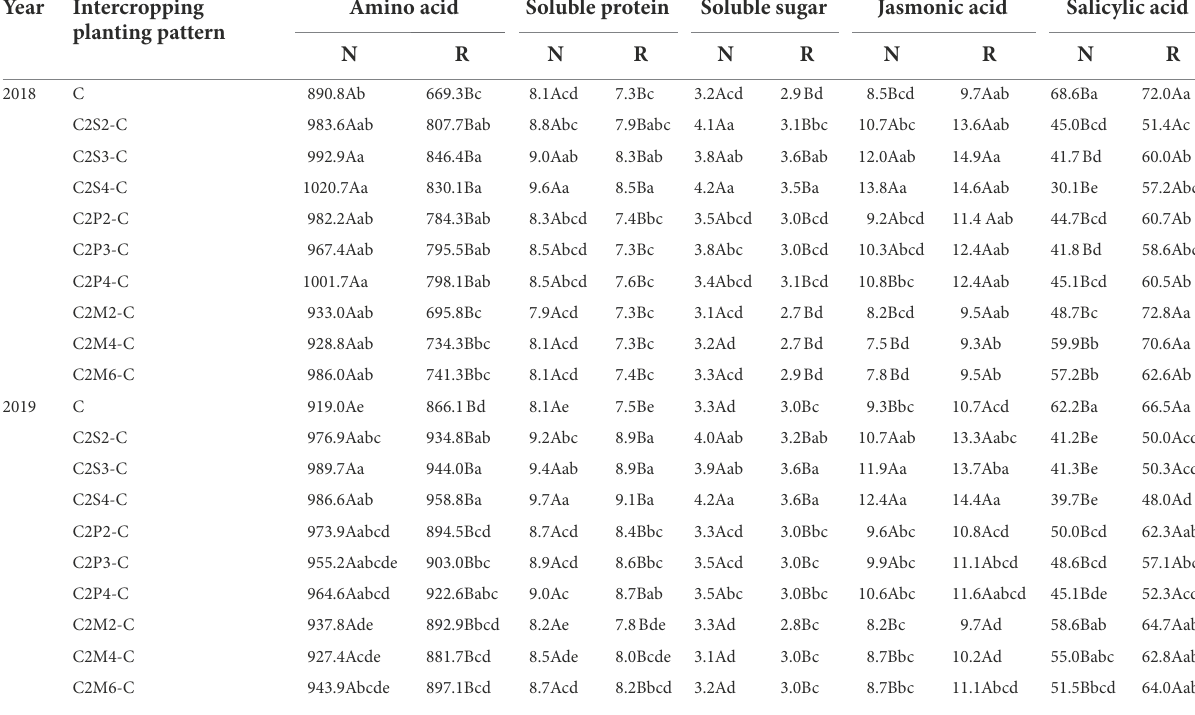
TABLE 4 Effects of different intercropping planting patterns and fertilizer levels on the contents of nutrients (AA, SP and SS) and secondary metabolites (JA and SA) in corn leaves in 2018 and 2019. Year Intercropping planting